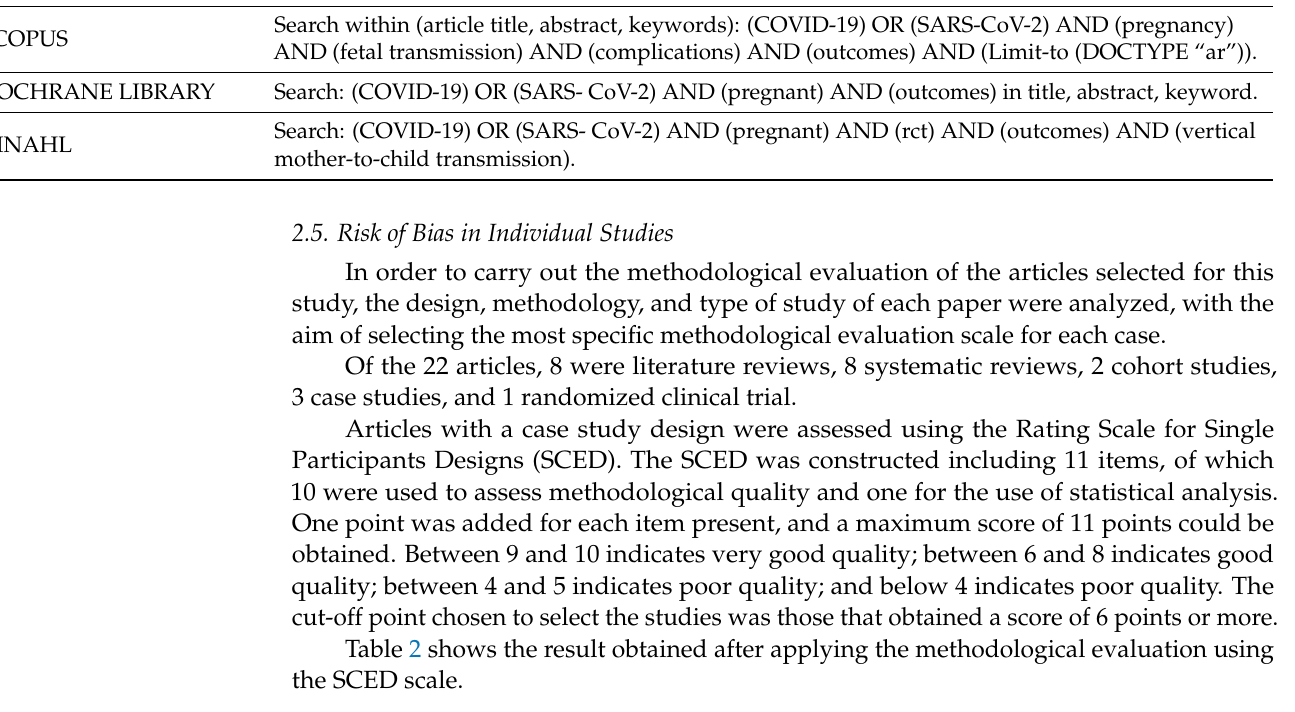
Table 2. Methodological assessment according to the SCED